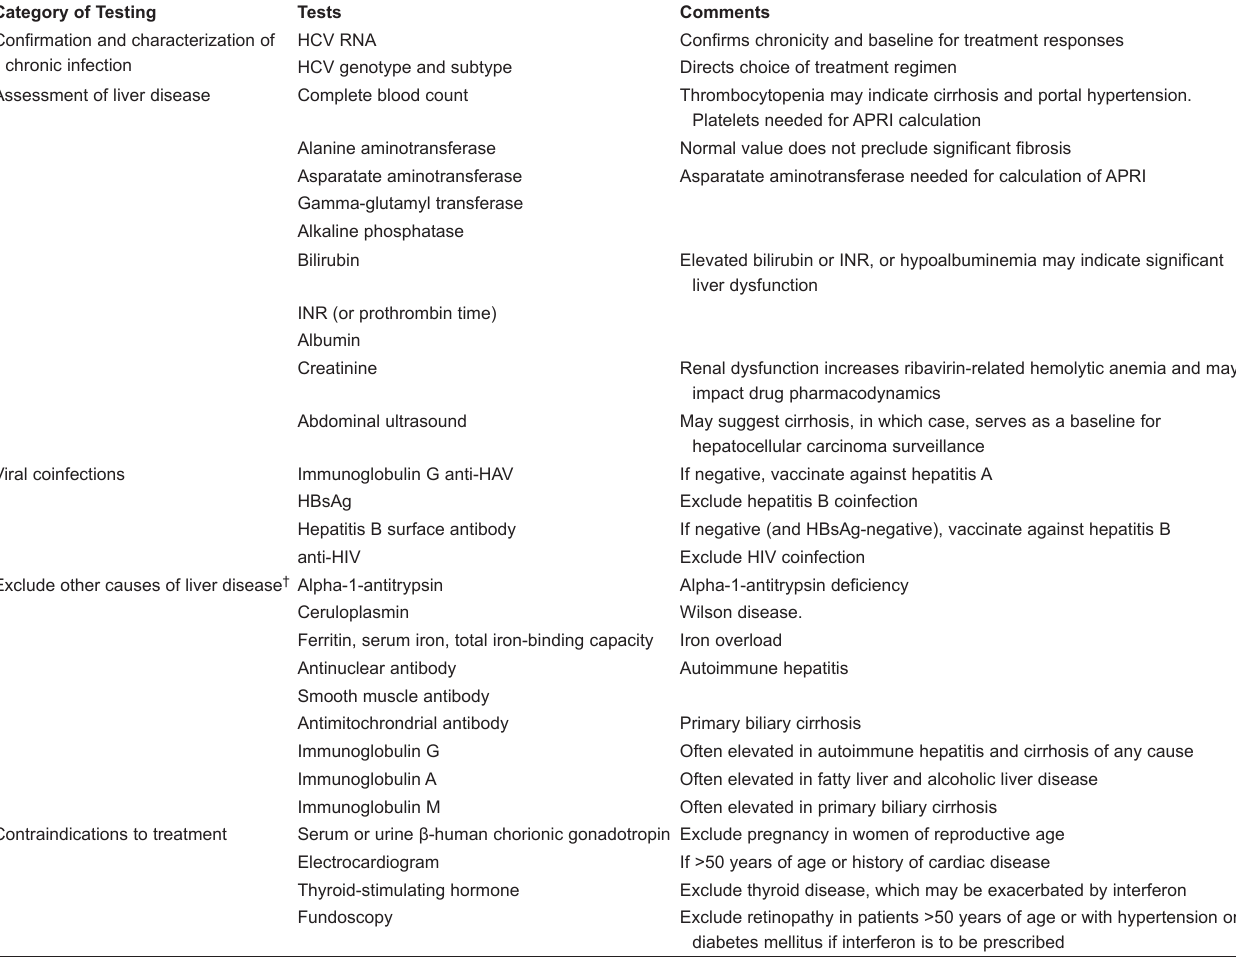
TABle 3 Routine testing of patients with chronic hepatitis C virus (HCV)* Category of